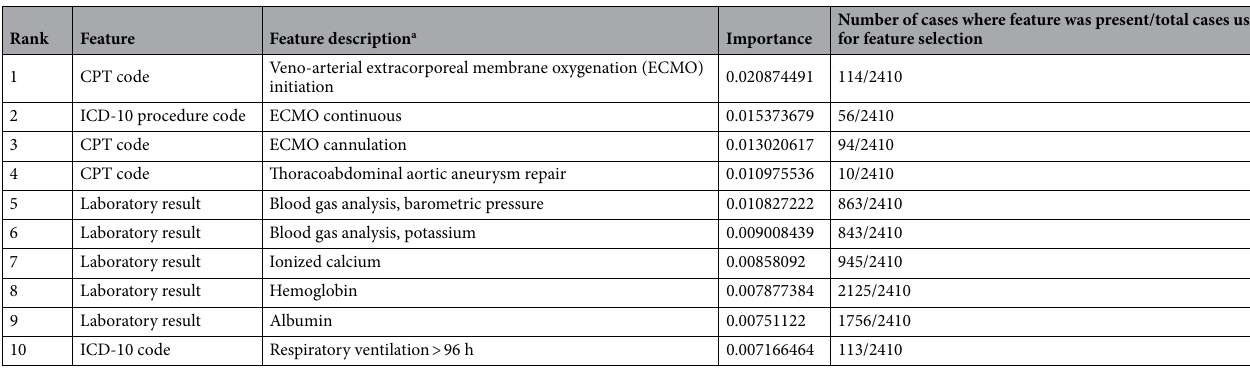
Table 2. Top 10 features after random forest feature selection. CPT current procedural terminology, ICD international classification of diseases. a All features used were only applied if they were known to be available for the patient prior to the surgery start time. Features (e.g. laboratory values, billing codes) were excluded from the model for a given patient if they were not available before the surgery start time.